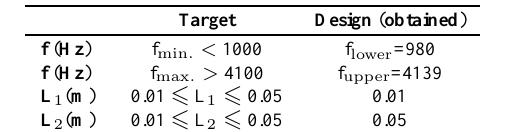
Table 2 Target and design values for example 2